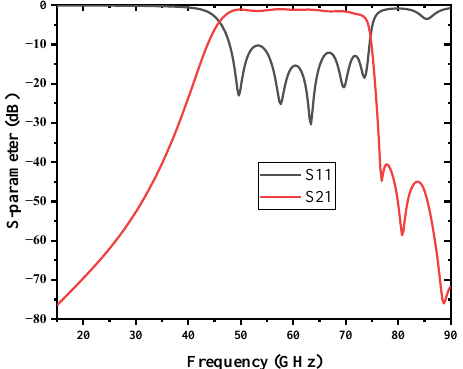
Figure 6. Simulation results of the BPF based on SIW and